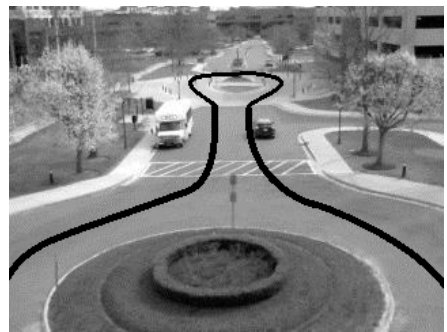
Figure 7. Overlaid path on an image from the Johns Hopkins University (JHU) balcony trial.